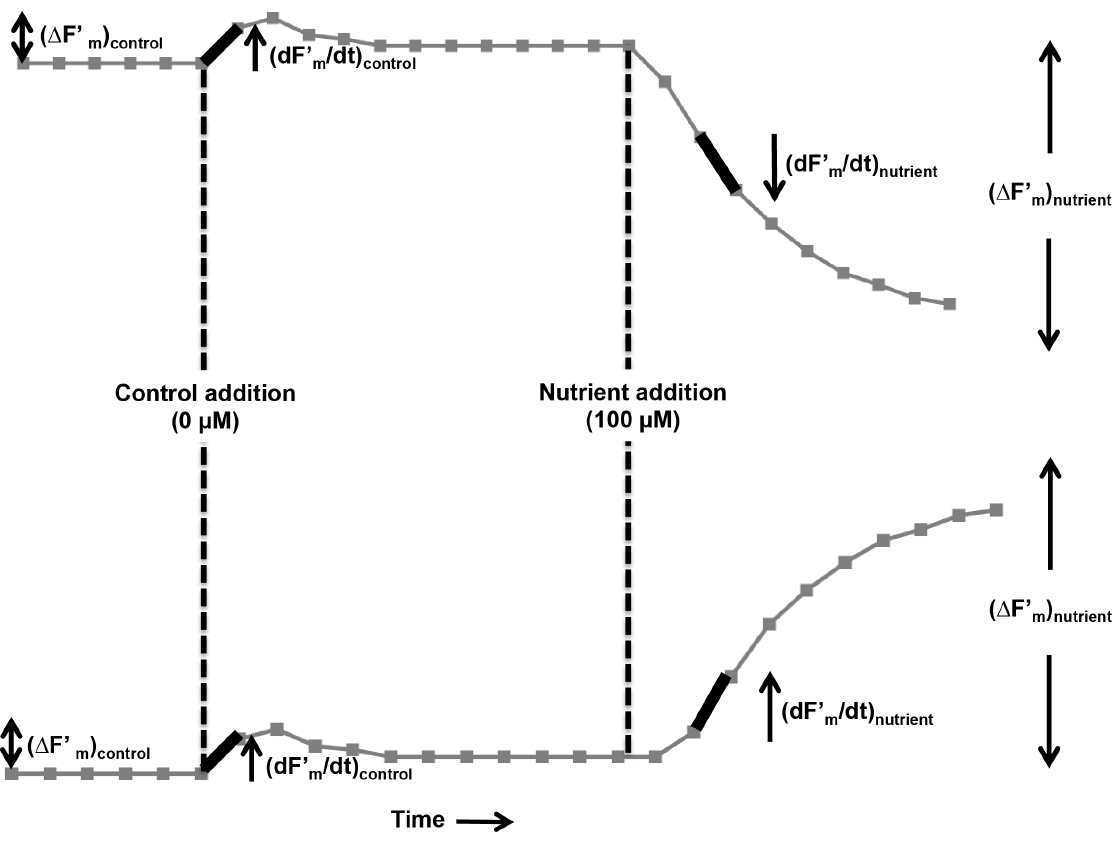
Figure 3. How to determine a NIFT response? Schematic overview of the two criteria used to assess the presence or absence of a NIFT response upon nutrient addition during two possible NIFT reactions. The first criterion compares the rate of change in maximum fluorescence induced by nutrient addition ((dF 9 m /dt) nutrient ) versus that induced by the control solution ((dF 9 m /dt) control ). The second criterion compares the total change in maximum fluorescence induced by nutrient addition (( D F 9 m ) nutrient ) versus that induced by the control solution (( D F 9 m ) control ).